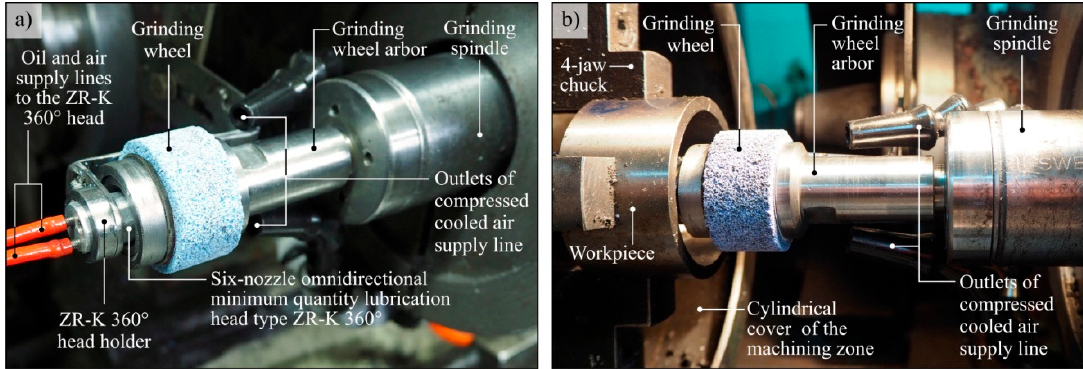
Figure 1. View of centrifugal MQL-CCA method components ( a ) installed in the grinding zone ( b ).